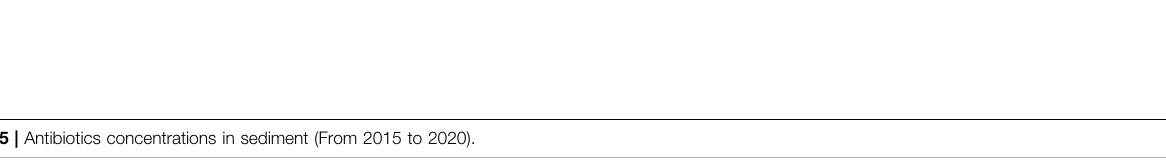
TABLE 5 | Antibiotics concentrations in sediment (From 2015 to 2020).